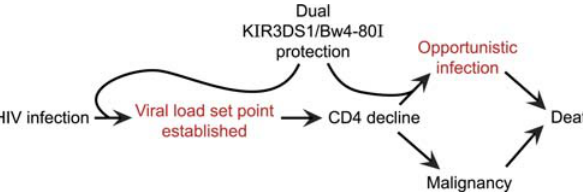
Figure 2. Bimodal Protection of KIR3DS1 / HLA-B Bw4-80I in HIV-1